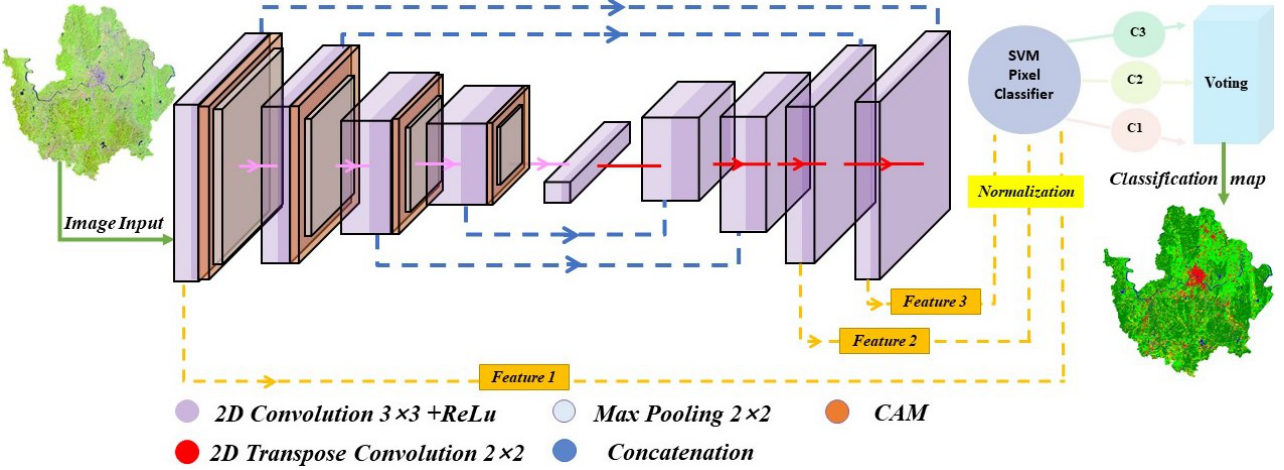
Figure 2. Algorithm network